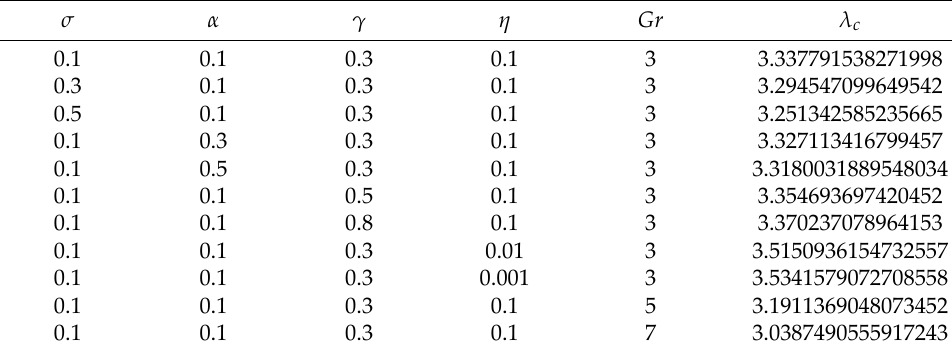
Table 4. Thermal stability with values when δ = 0.2, Bi 1 = 10 = Bi 2 , m = 0.5, ε = 0.1